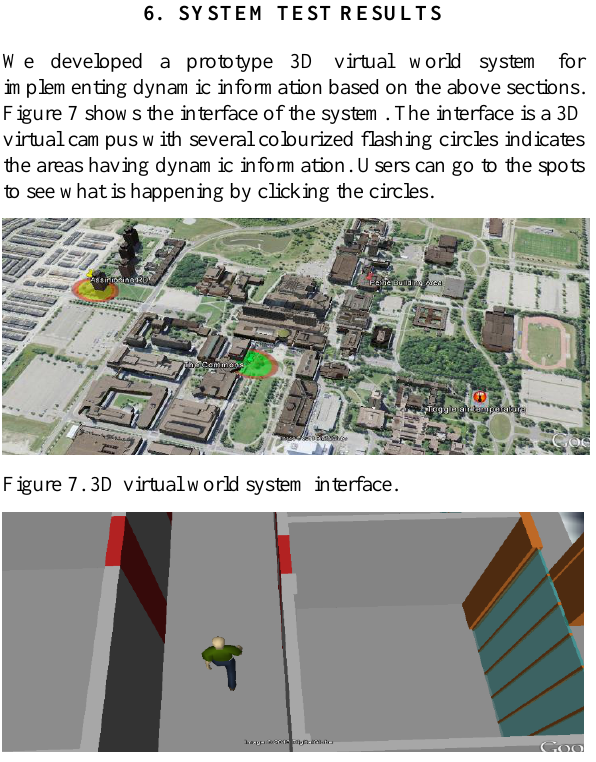
Figure 8. Indoor positioning based on WiFi technique. Detected person can be visualized using simple 3D avatar.